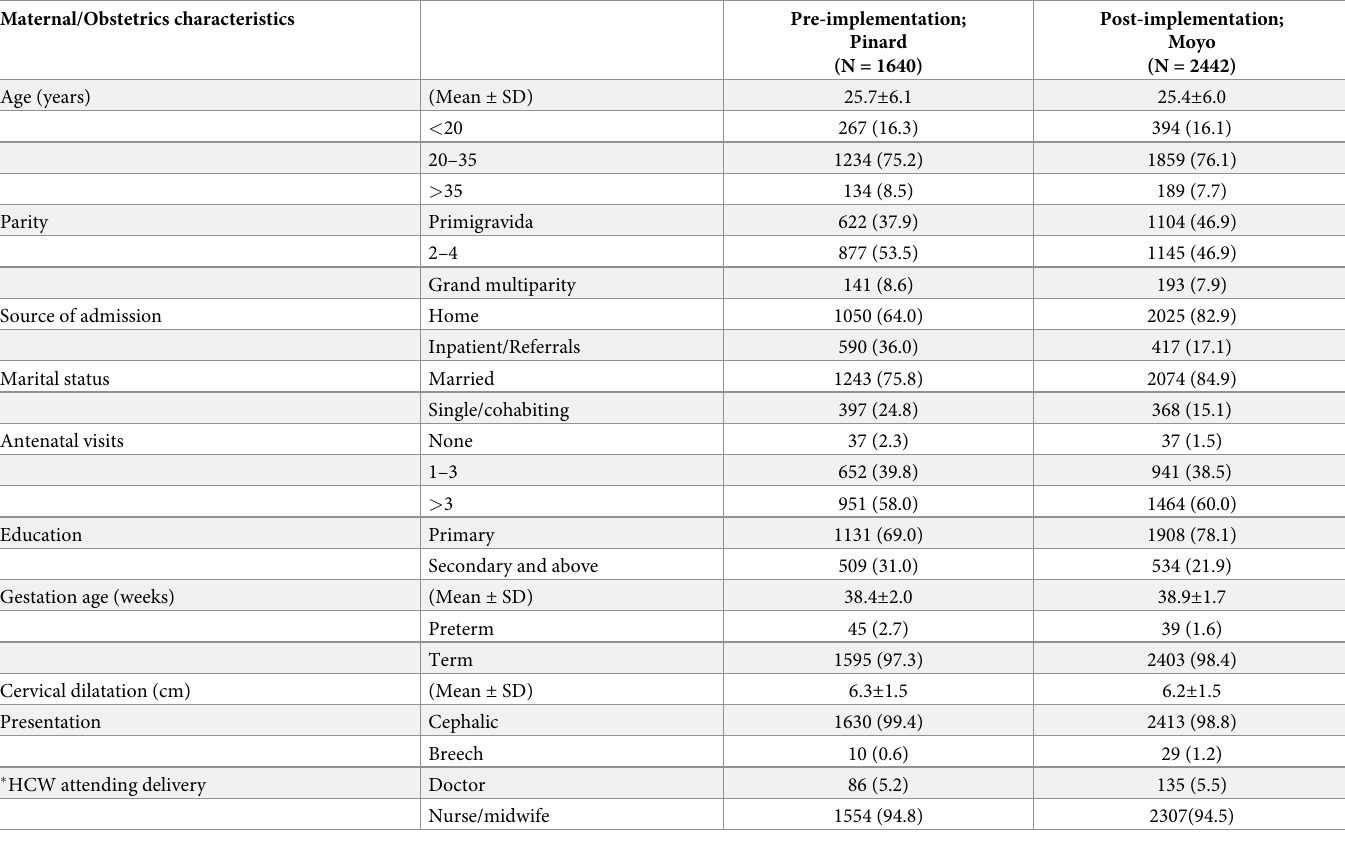
Table 1. Baseline maternal and obstetric characteristics of women admitted in the labor ward at temeke hospital pre- and post-implementation of a continuous automatic Doppler (Moyo) from March to December 2016. Maternal/Obstetrics